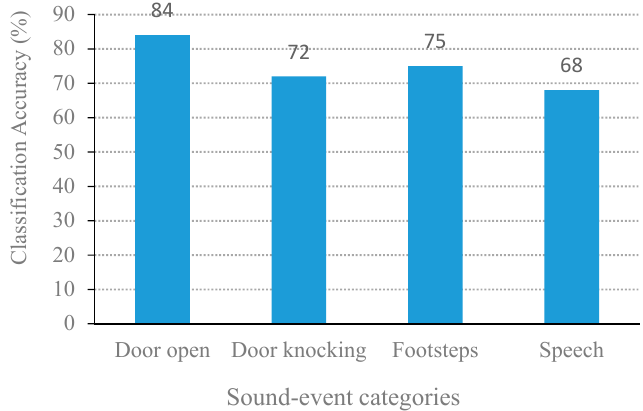
Figure 9. Average percentage of classification accuracy from the perspective of event group of the proposed NSSEC method .